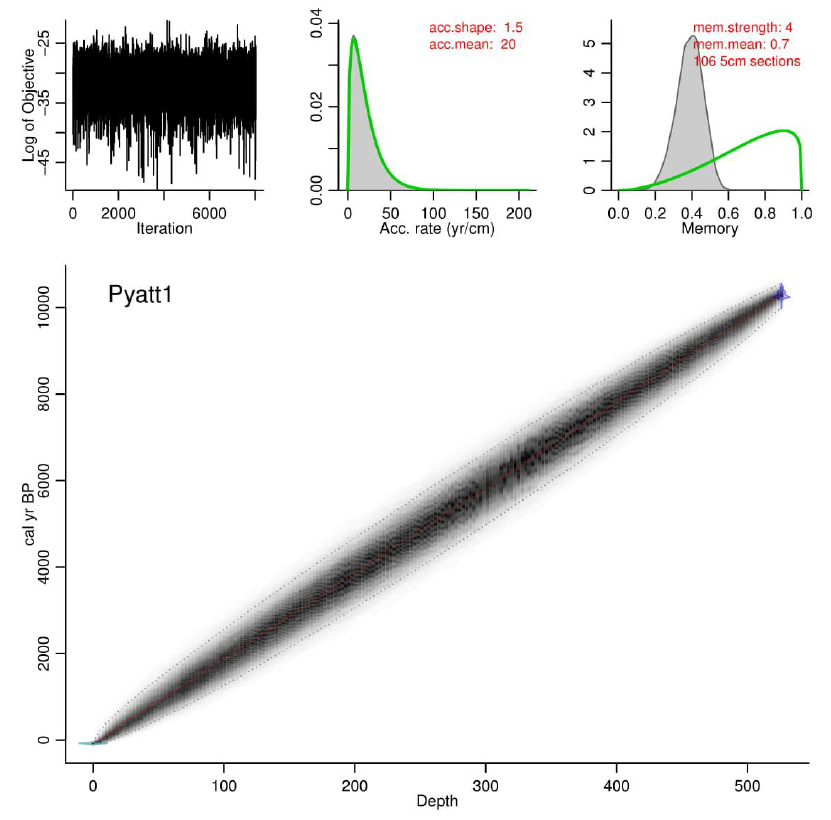
Figure A3k. Age-depth model produced in BACON for BADP1.